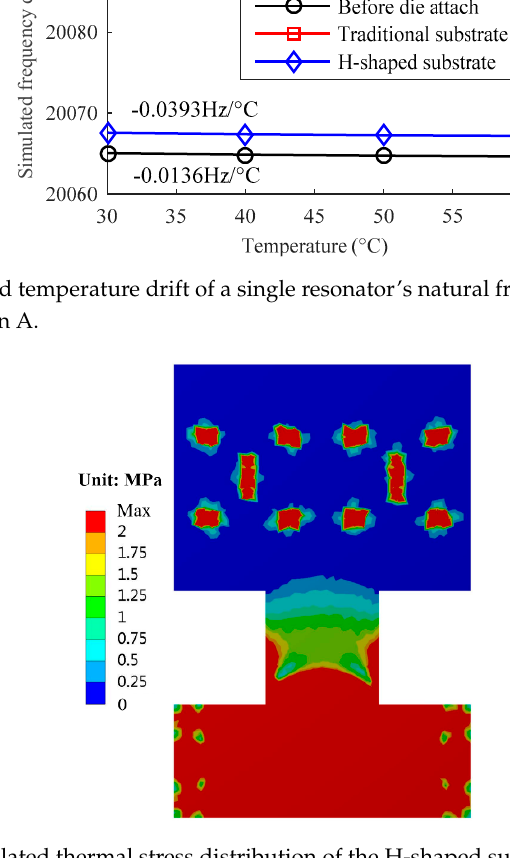
Figure 5. The simulated thermal stress distribution of the H-shaped substrate after die attach.